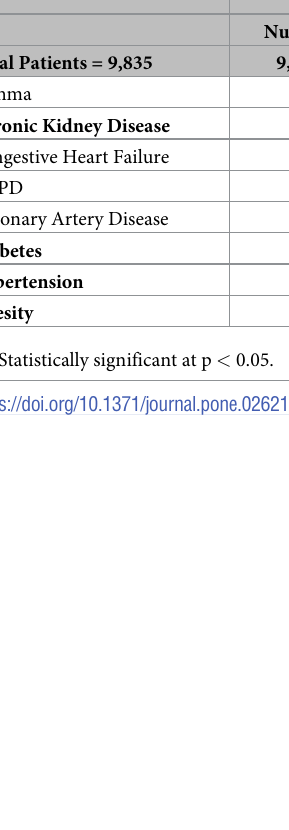
Table 2. Comorbidity characteristics of patients by COVID status.